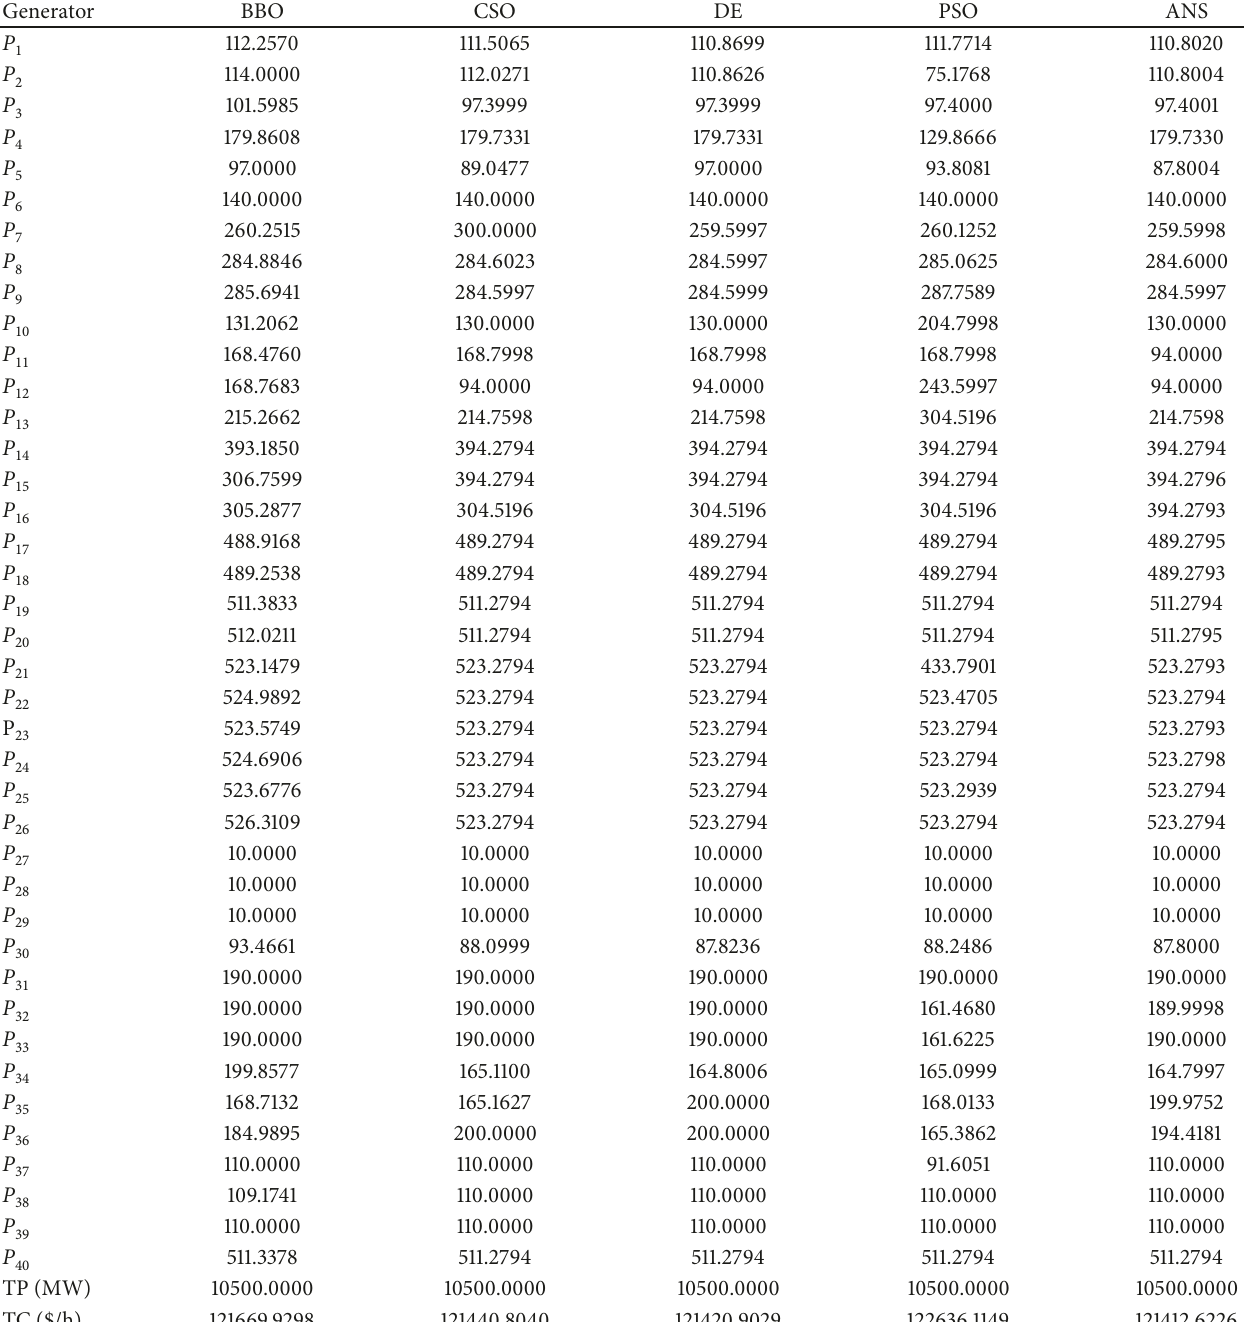
Table 9: Best output power for 40-generator system (Case IV).